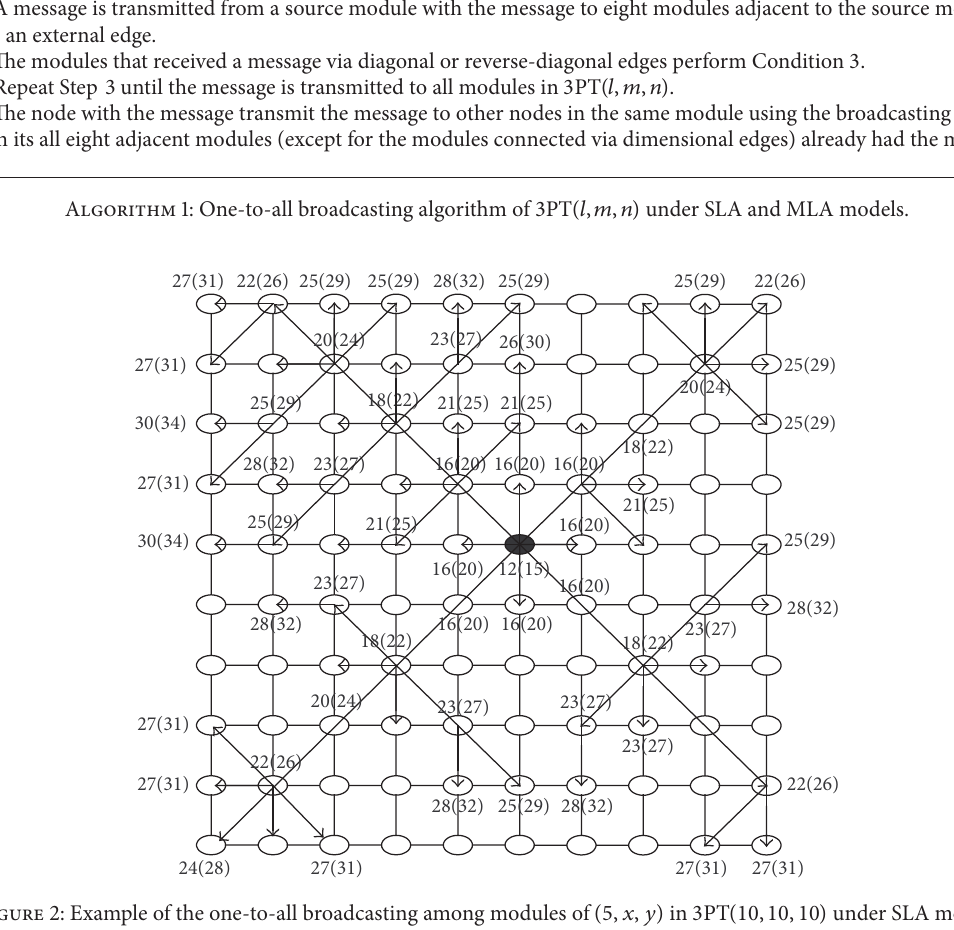
Figure 2: Example of the one-to-all broadcasting among modules of (5, 𝑥,𝑦) in 3 PT (10,10, 10) under SLA model. for the source and destination modules is ⌊𝑚/2⌋ − 1 . The internal broadcasting time for the destination module is 4 under SLA model by Lemma 3. Therefore, the broadcasting time for this case is 2⌊𝑙/2⌋ + 2⌊𝑚/2⌋ + 9 when 𝑙 = odd and 𝑙 + 2⌊𝑚/2⌋ + 8 when 𝑙 =